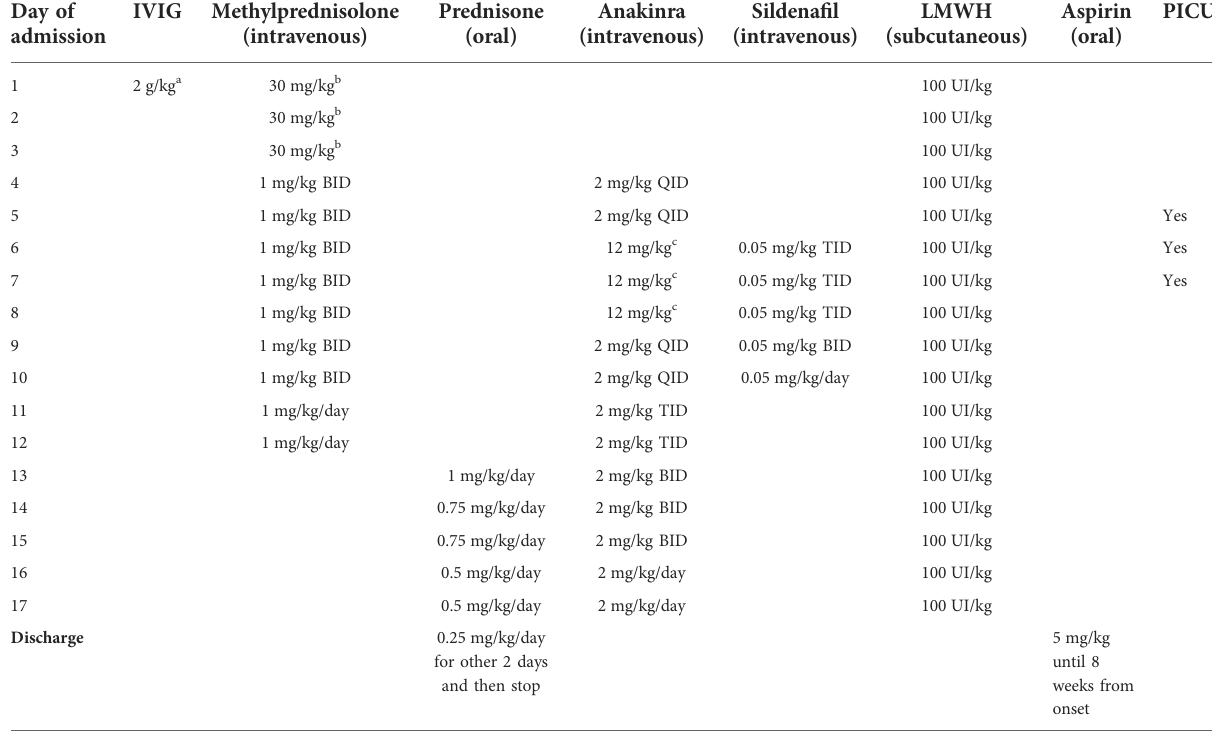
TABLE 1 Summary of the immunomodulatory and thromboprophylaxis therapy administered to our patient affected by MIS-C complicated with pulmonary